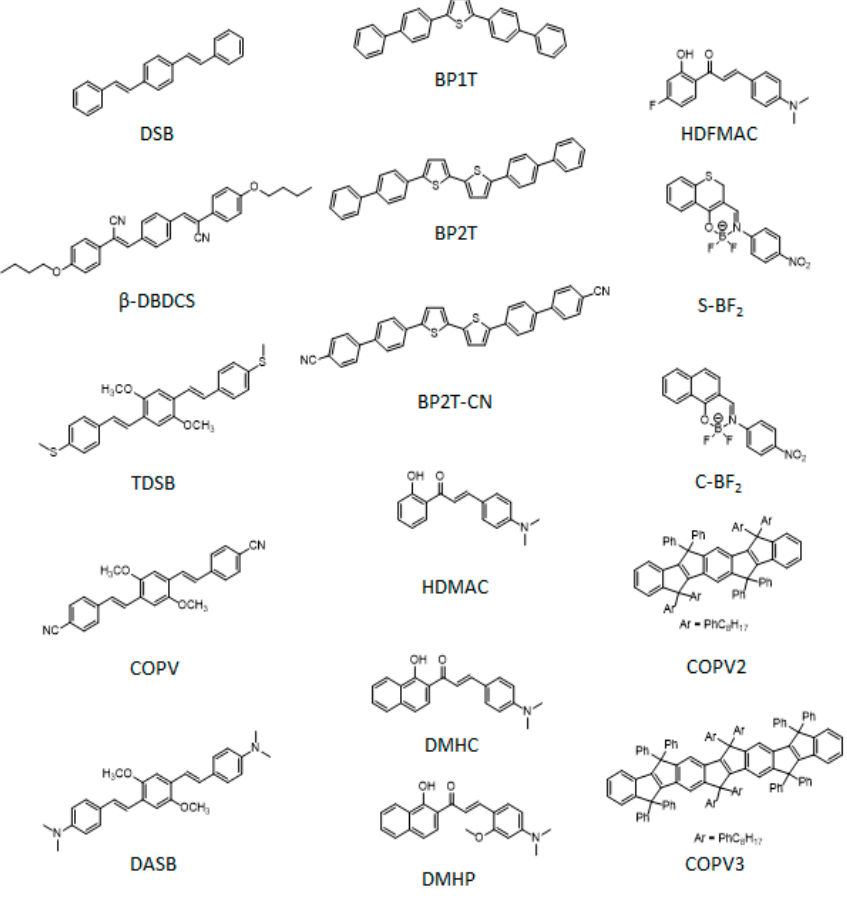
Figure 13. Chemical structures of compounds featuring in Table 1. Table 1. Crystallographic and photophysical emission data of organic π -conjugated materials.